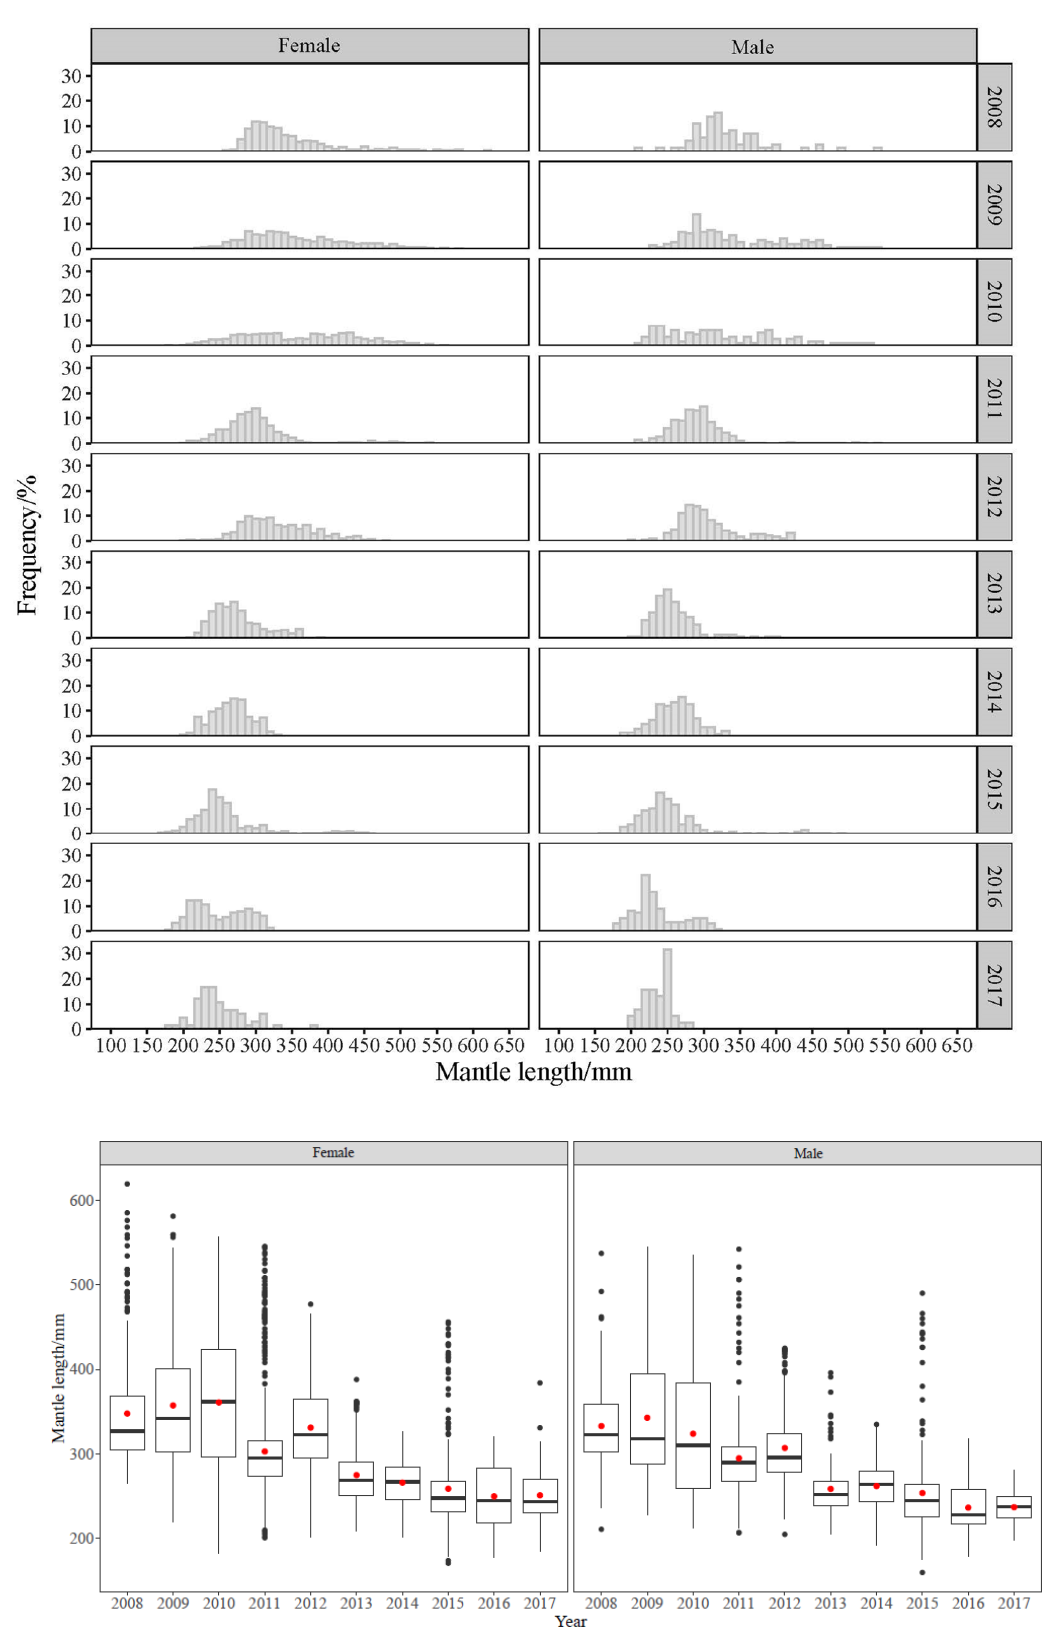
Figure 4. Distribution of mantle length of D. gigas in different years. The boxes show the median and the interquartile range. The black dots are indications of outliers in the data. The red dots show the mean.